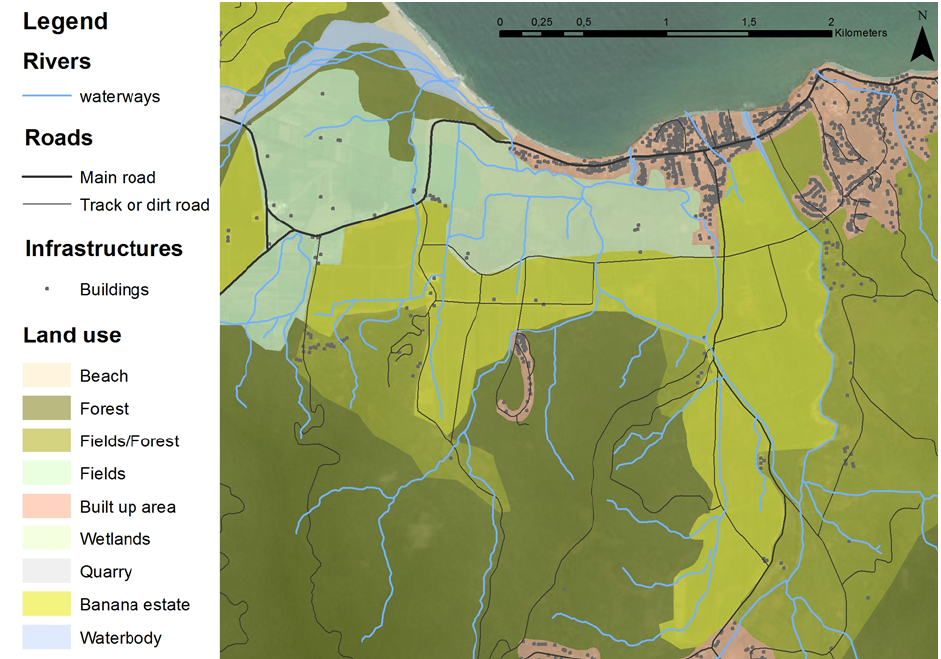
Figure 1. Situation map Annotto Bay, Jamaica (Glas et al.,